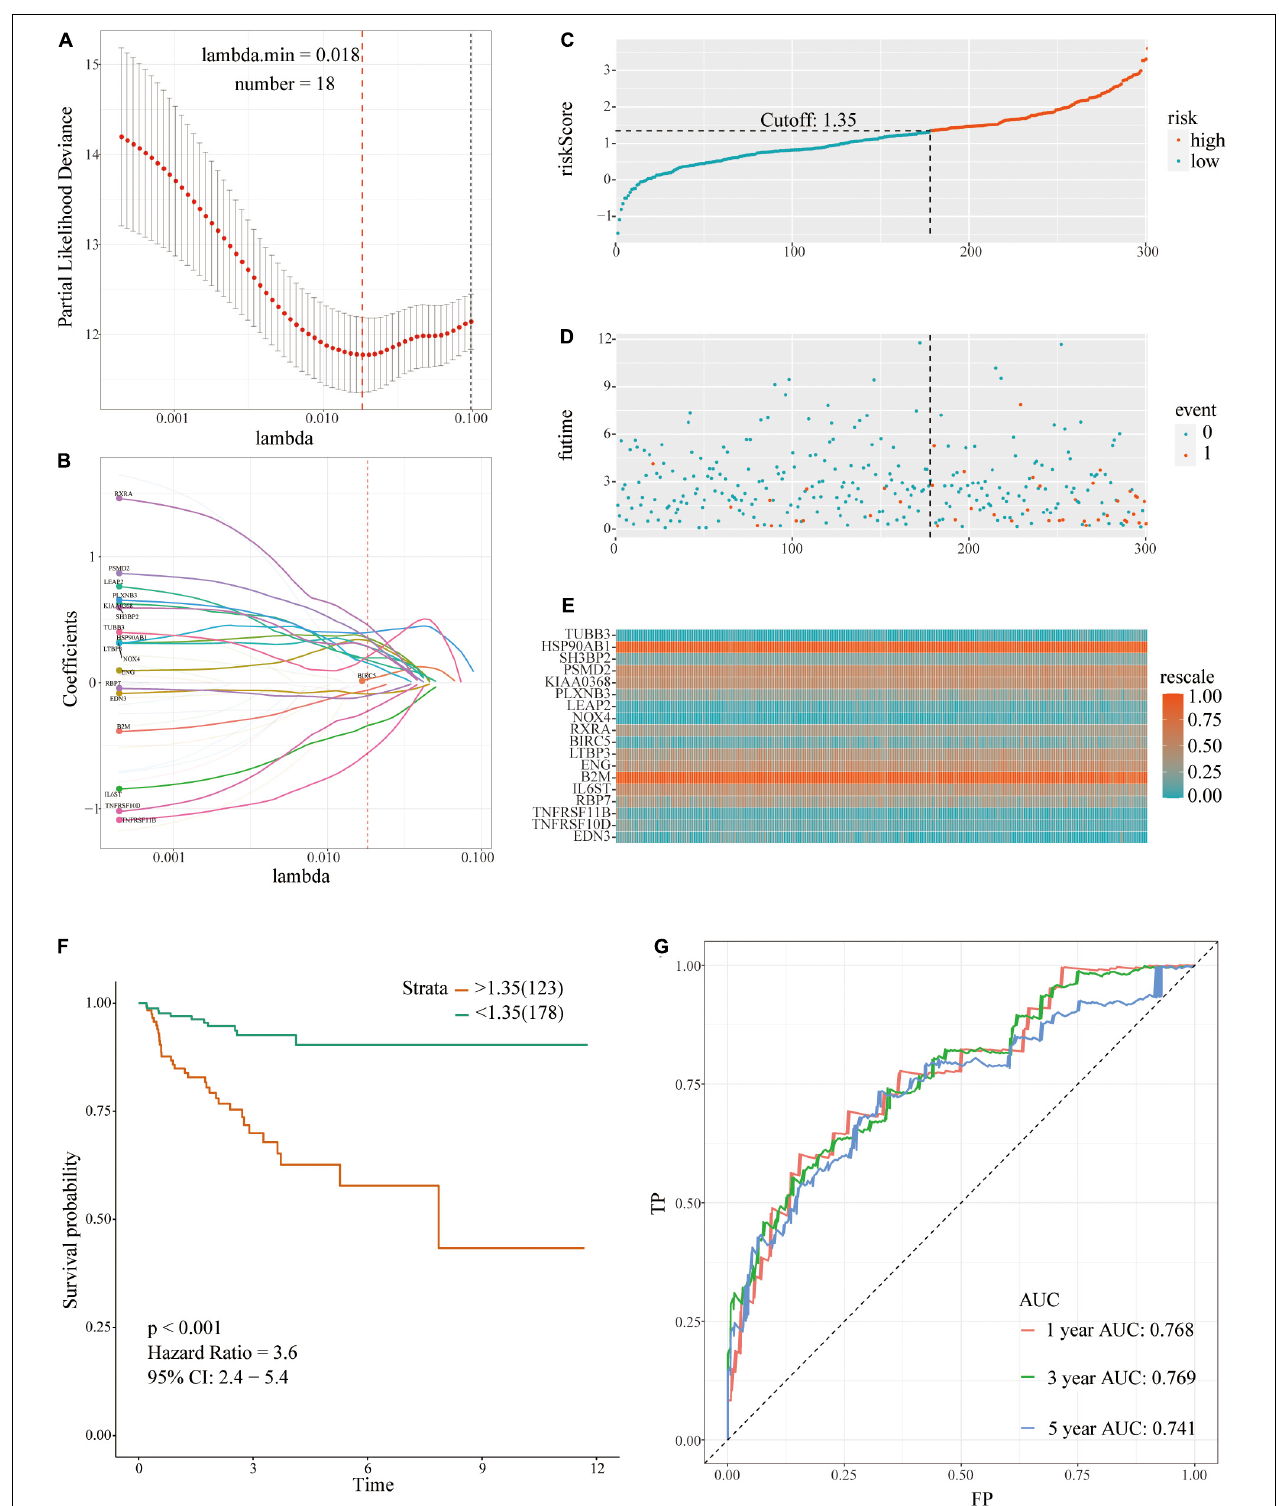
FIGURE 3 | A prognostic signature based on IRGs in the TCGA-training set. (A,B) Identification of 18 IRGs by LASSO regression analysis; (C) Distribution of risk scores based on IRGs in PCa; (D) Recurrence status of patients in different groups; (E) Heatmap showing the expression profiles of IRGs; (F) Survival analysis for the signature-defined risk groups; (G) Time-dependent ROC curve of the 18-IRGs prognostic signature.